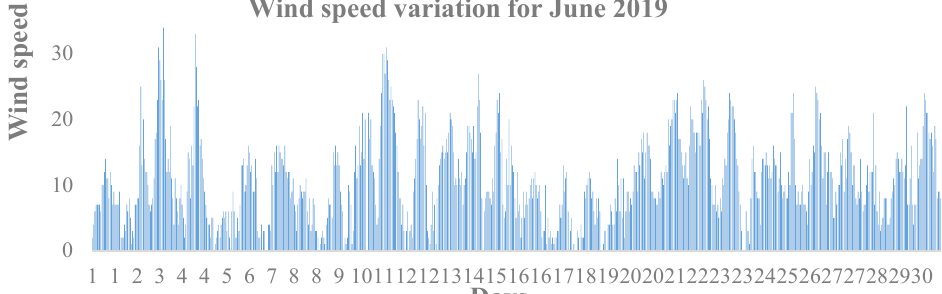
Figure 28. Wind speed variation in Ottawa region.